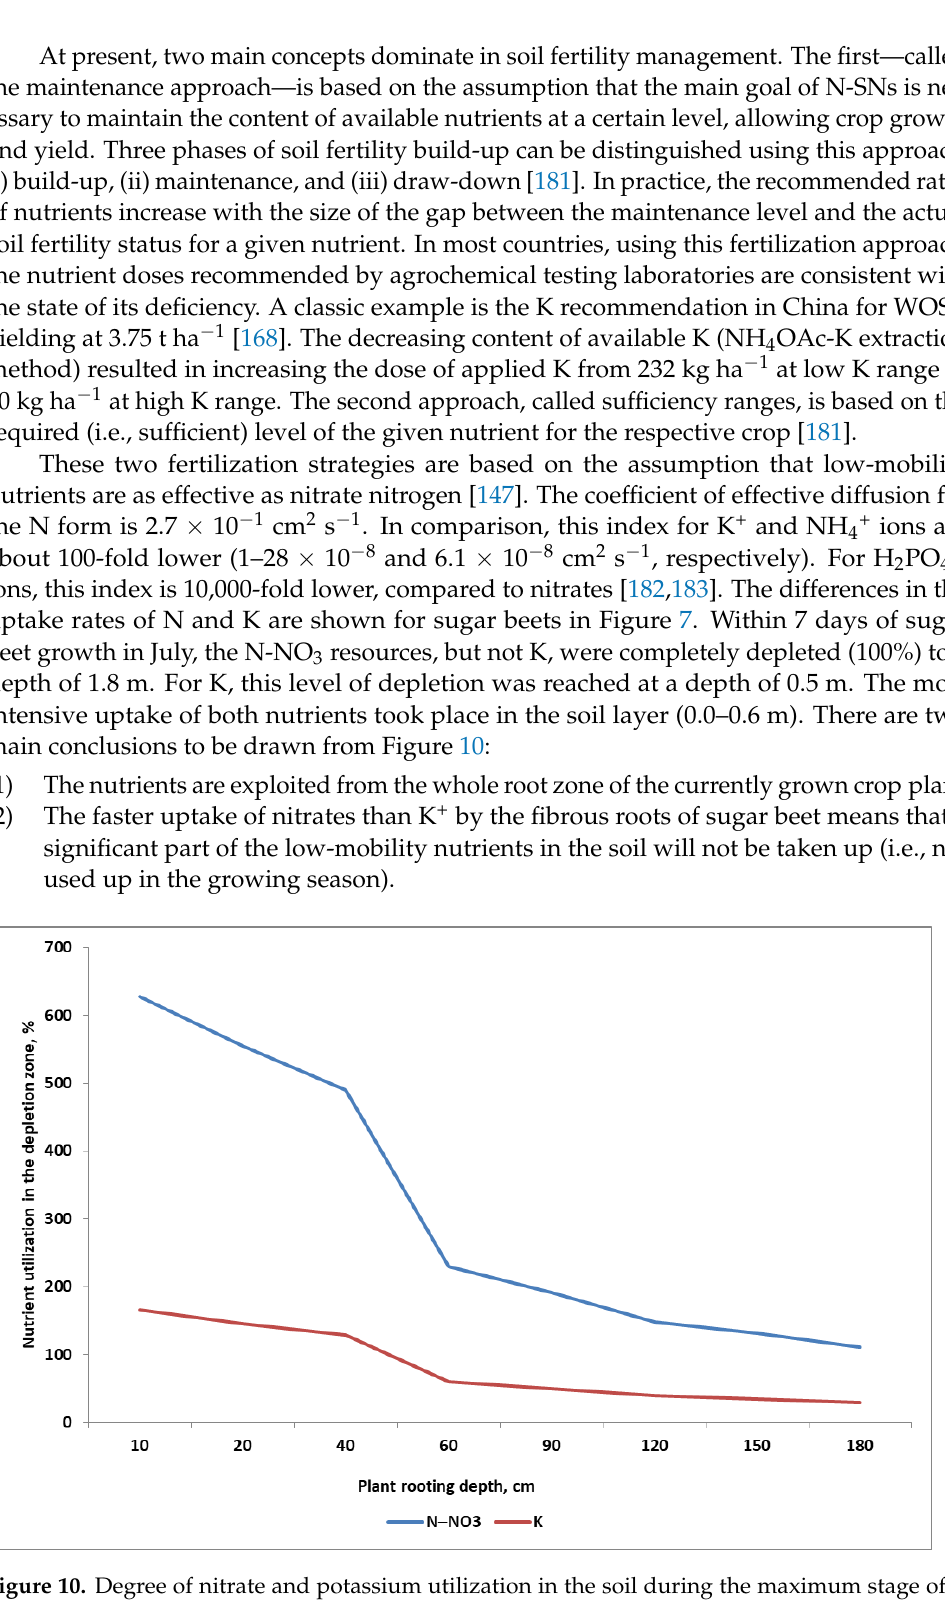
Figure 10. Degree of nitrate and potassium utilization in the soil during the maximum stage of K accumulation by sugar beets (based on [74]).